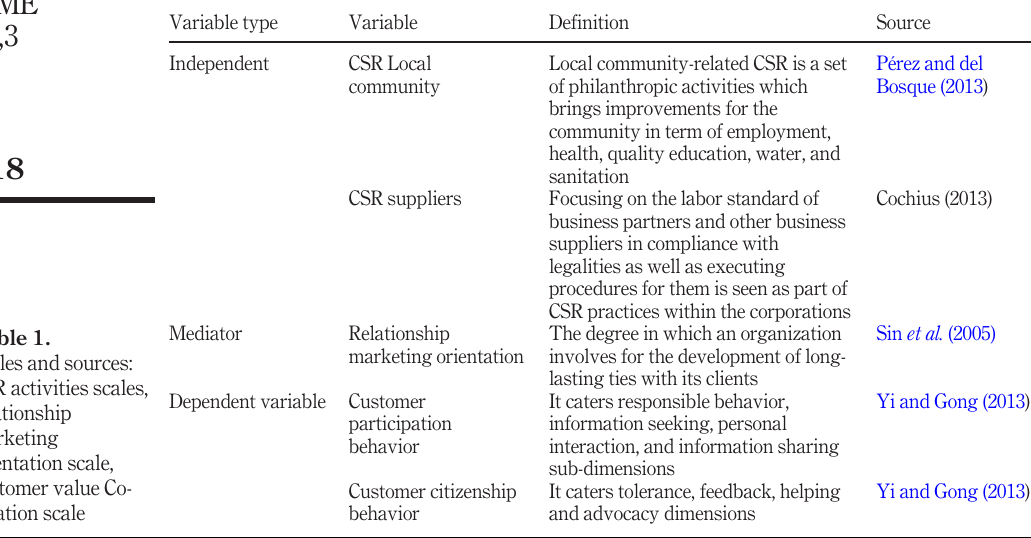
Table 1. Scales and sources: CSR activities scales, relationship marketing orientation